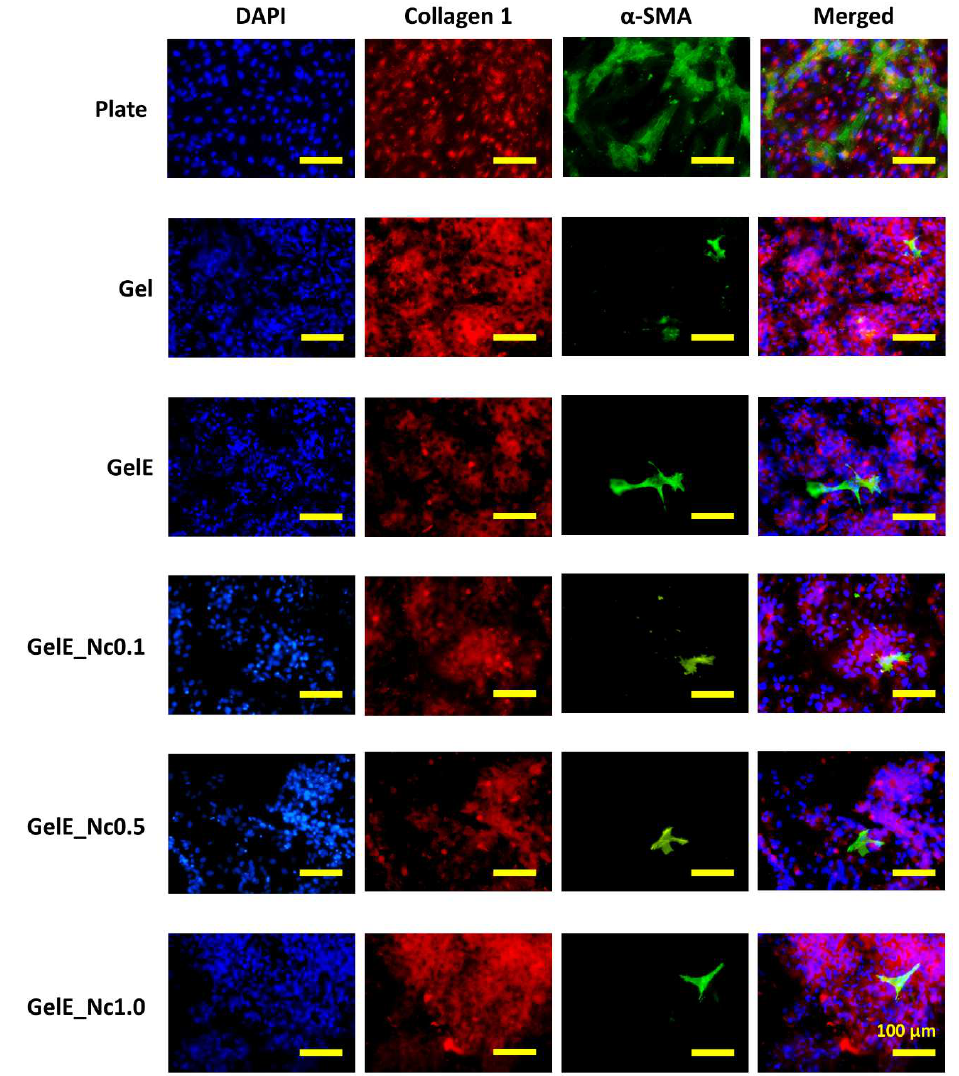
Figure 6. Fluorescent imaging of the HDF cultured on the scaffolds. The group labelled “Plate” represents HDF grown on culture plates. HDF were stained for collagen type I (red), α-SMA (green). Nucleus counterstain was performed with DAPI (blue). All of the proteins were able to be expressed on the scaffolds. The yellow scale bar represents 100 μm.